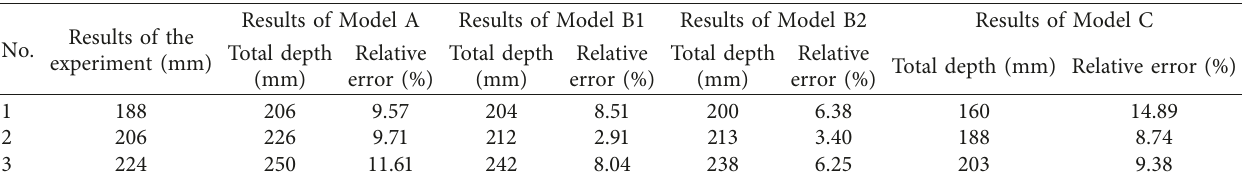
Table 10: Depth of penetration results of numerical simulation and experiments.